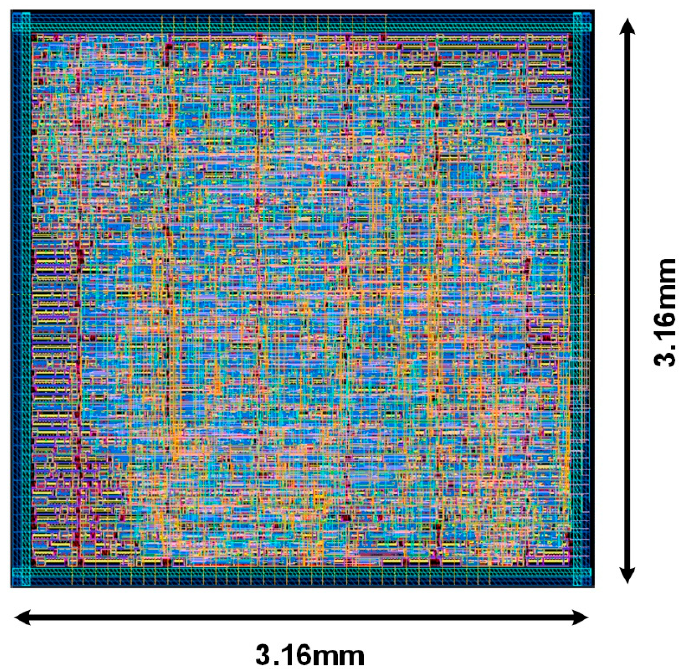
Figure 22. The layout of the proposed CNN system.